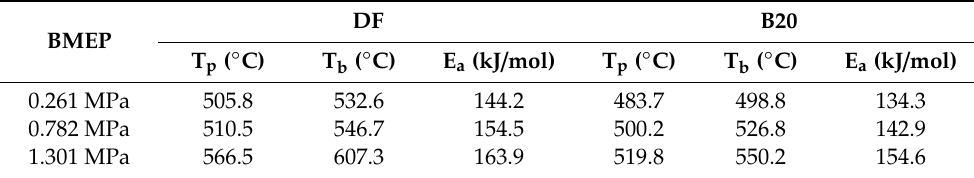
Table 4. Peak temperature (T p ), burnout temperature (T b ) and apparent activation energy (E a ) for soot samples.